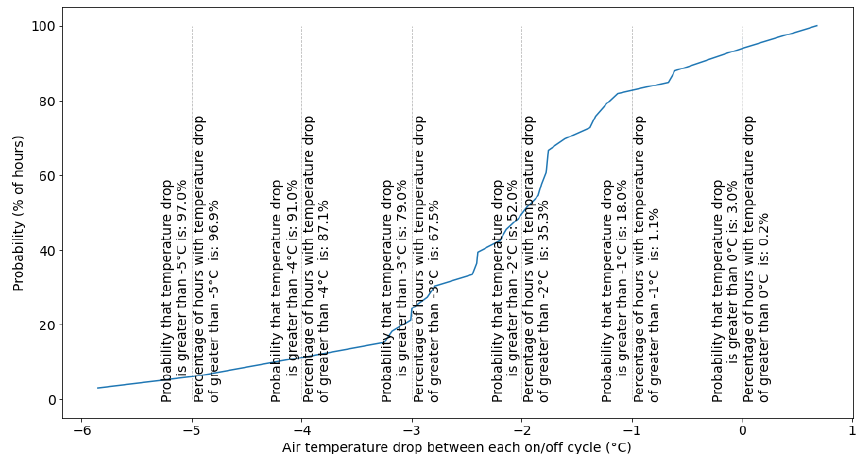
Figure 14. ECDF of air temperature drop between each on/off cycle.